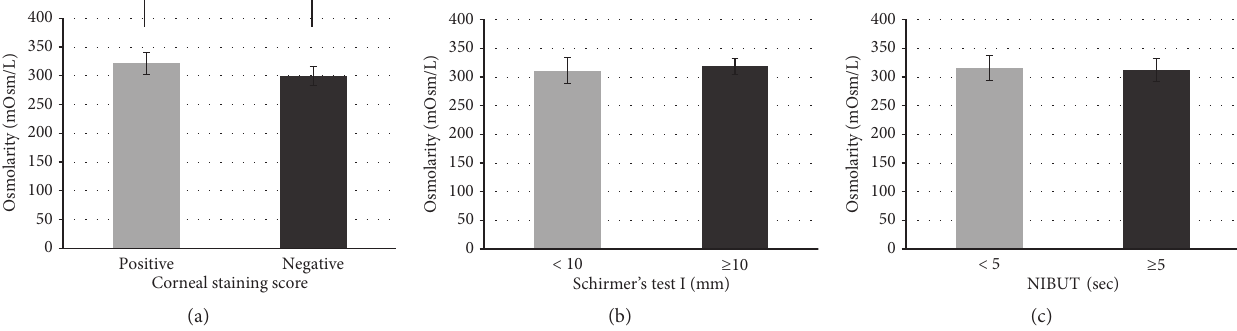
Figure 2: Comparison of osmolarity between ocular parameter groups stratified by dry eye severity. (a) Corneal staining scores, (b) Schirmer’s test I, and (c) noninvasive tear break up time (NIBUT). ∗ Indicates statistical significance ( p < 0 .